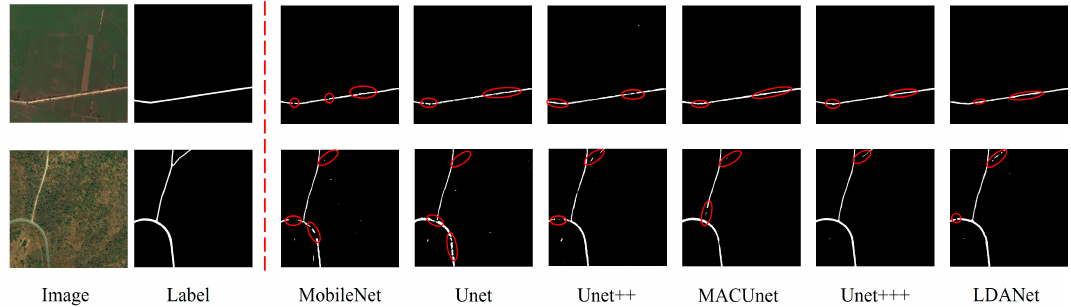
Figure 6. Extraction results of six models on the rural roads dataset.